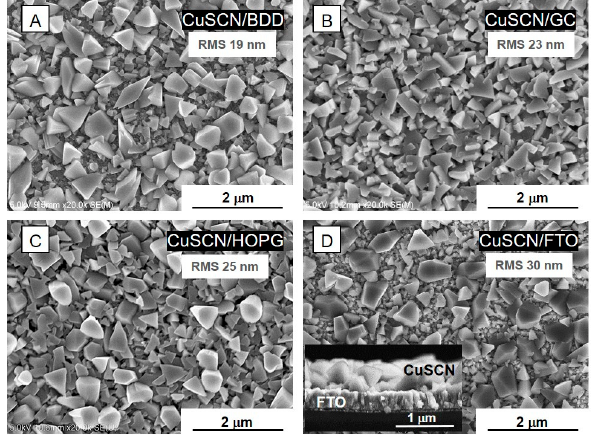
Figure 1. SEM images of CuSCN electrodeposited on ( A ) boron-doped diamond (CuSCN/BDD), ( B ) glass-like carbon (CuSCN/GC), ( C ) highly ordered pyrolytic graphite (CuSCN/HOPG) and D) F-doped SnO 2 glass (CuSCN/FTO). The inset of chart ( D ) shows the cross-sectional view. Ex situ Raman spectra in the range of 100–2400 cm − 1 of the pristine dry CuSCN layers electrodeposited on various substrates (BDD, GC, HOPG, FTO), as well as spectra of bare substrates with their characteristic Raman features [45,49,53,54] are shown in Figure 2A. Raman spectrum of single-crystal graphite (sp 2 carbon) exhibits only one narrow peak at ~1580 cm − 1 (E 2g phonon, designated as the G mode) in this range [55], while polycrystalline graphite or amorphous sp 2 carbon (like GC) have an additional peak at ~1350 cm − 1 (A 1g phonon, D mode) [54], whose intensity reflects the effective crystallite size L a [56]. The Raman spectrum of diamond (sp 3 carbon) exhibits a narrow natural single line at 1332 cm − 1 [57] identified as the three-fold degenerate, zone-center optical mode at the Γ point and additional broad, weak-intensity peaks near 1580 cm − 1 , which indicate the presence of a small amount of sp 2 impurities in the films [58]. Bands corresponding to the vibrations associated with the increased boron concentration in BDD start to appear at ~500 and ~1225 cm − 1 . This is accompanied by an increase in electrical conductivity and transition from semimetallic to metallic character of BDD (B content in diamond lattice > 3 × 10 20 cm − 3 [59]). At the same time, the characteristic diamond line at 1332 cm − 1 downshifts, attenuates and exhibits an asymmetric Fano-like line shape [45,60]. The bands of graphitic or amorphous carbon impurities in BDD (depending on the film quality) are located at 1335 cm − 1 (D band), 1580 cm − 1 (G band), 1610 cm − 1 (D band) and 1520 cm − 1 (tetrahedral amorphous carbon) [45,49]. The Raman bands of pristine FTO are located at 480, 500 and 1080 cm − 1 [53]. Independently of the substrate type, the Raman spectra of CuSCN layers prepared by electrodeposition exhibit similar Raman features as the CuSCN layers prepared by spin-coating in our previous work [19]. In the higher frequency region (2000–2300 cm − 1 ), the electrodeposited CuSCN layers exhibit the peaks of ν as (C ≡ N) stretching mode, which is very sensitive to the local environment of the system as well as to the nature of the cation group [61] in thiocyanate resonant form of the SCN − ion. The weak peak at 2115 cm − 1 is assigned to the Cu − NCS isomer (Cu + − :N ≡ C − S − ) and the most intense peak at 2175 cm − 1 to the Cu − SCN isomer (Cu + − − S − C ≡ N). In the spin-coated CuSCN layers from our previous work [19], the most intense peak of the Cu − SCN isomer was red-shifted due to the different morphology of the spin-coated layers [62]. In the low-frequency region of 100–1000 cm − 1 , the presence of the thiocyanate SCN − resonant form is documented by the Raman peaks corresponding to the stretching modes of ν (Cu − S) at 205 cm − 1 , ν (Cu − N) at 241 cm − 1 and ν (C − S) at 746 cm − 1 and to the δ (SCN)